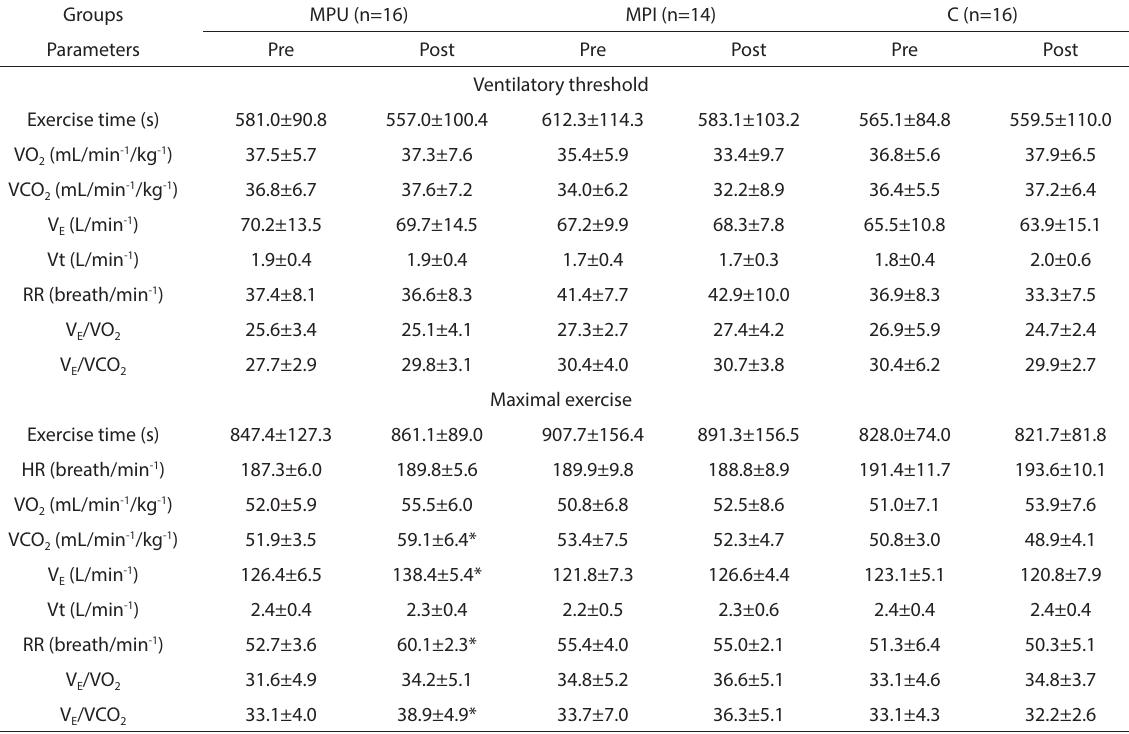
Table 4. Respiratory, cardiovascular and metabolic parameters during GXT after three interventions Groups